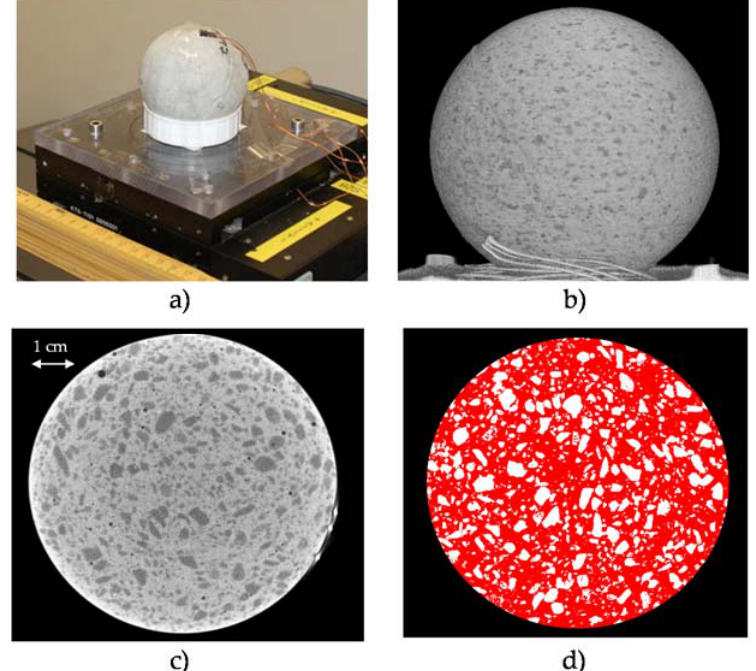
Figure 5.  3D ‐ XCT ‐ scans setup ( a and b ) and slices cross including image ‐ segmentation ( c and d ) of Figure 5. µ 3D-XCT-scans setup ( a , b ) and slices cross including image-segmentation ( c , d ) of the the spherical specimens. spherical